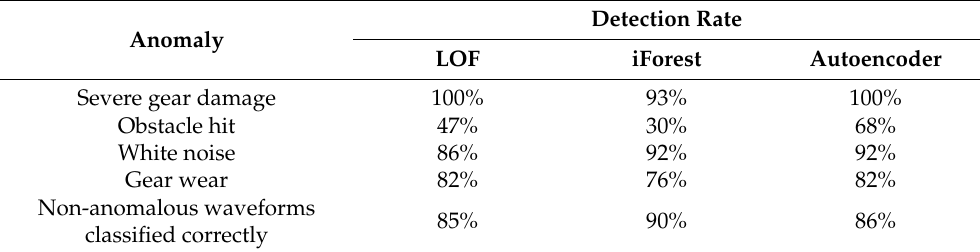
Table 3. Anomaly detection rate for the proposed approaches.